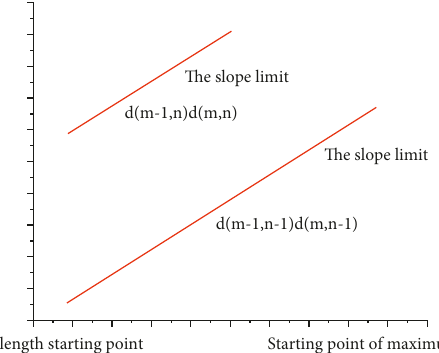
Figure 3: Dynamic gesture recognition process of the DTW